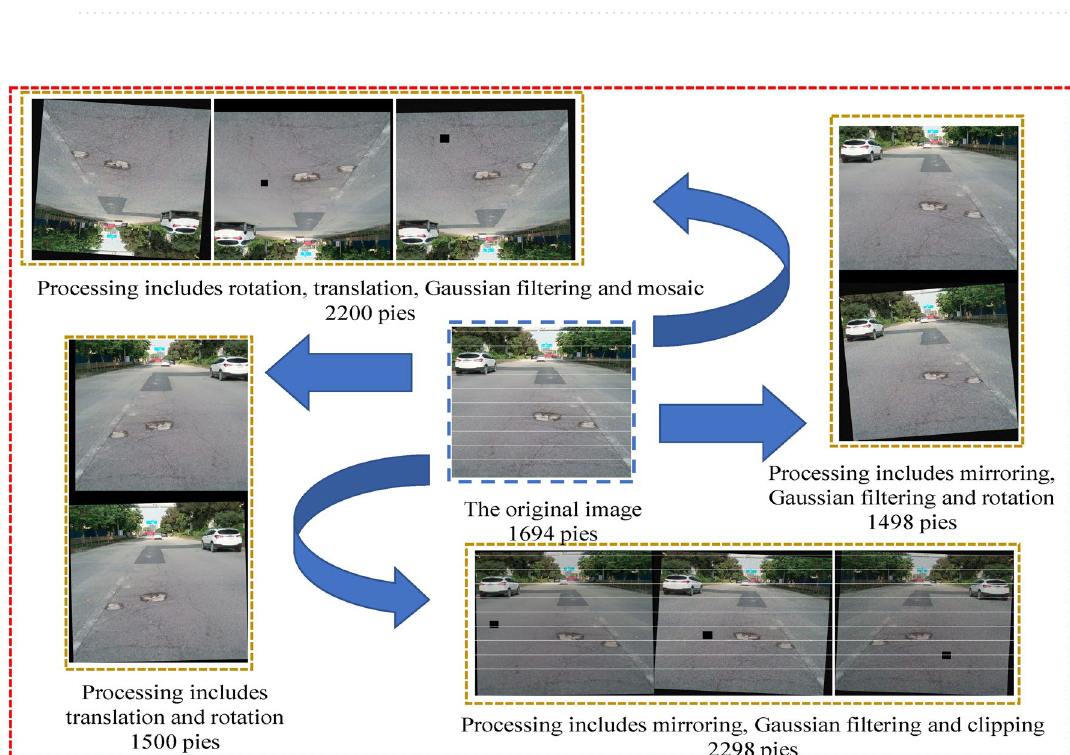
Figure 2. The distribution of training datasets